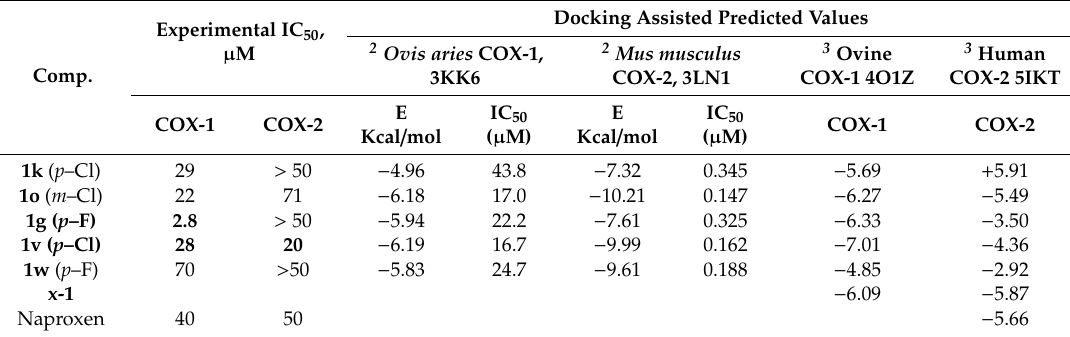
Docking Assisted Predicted Values